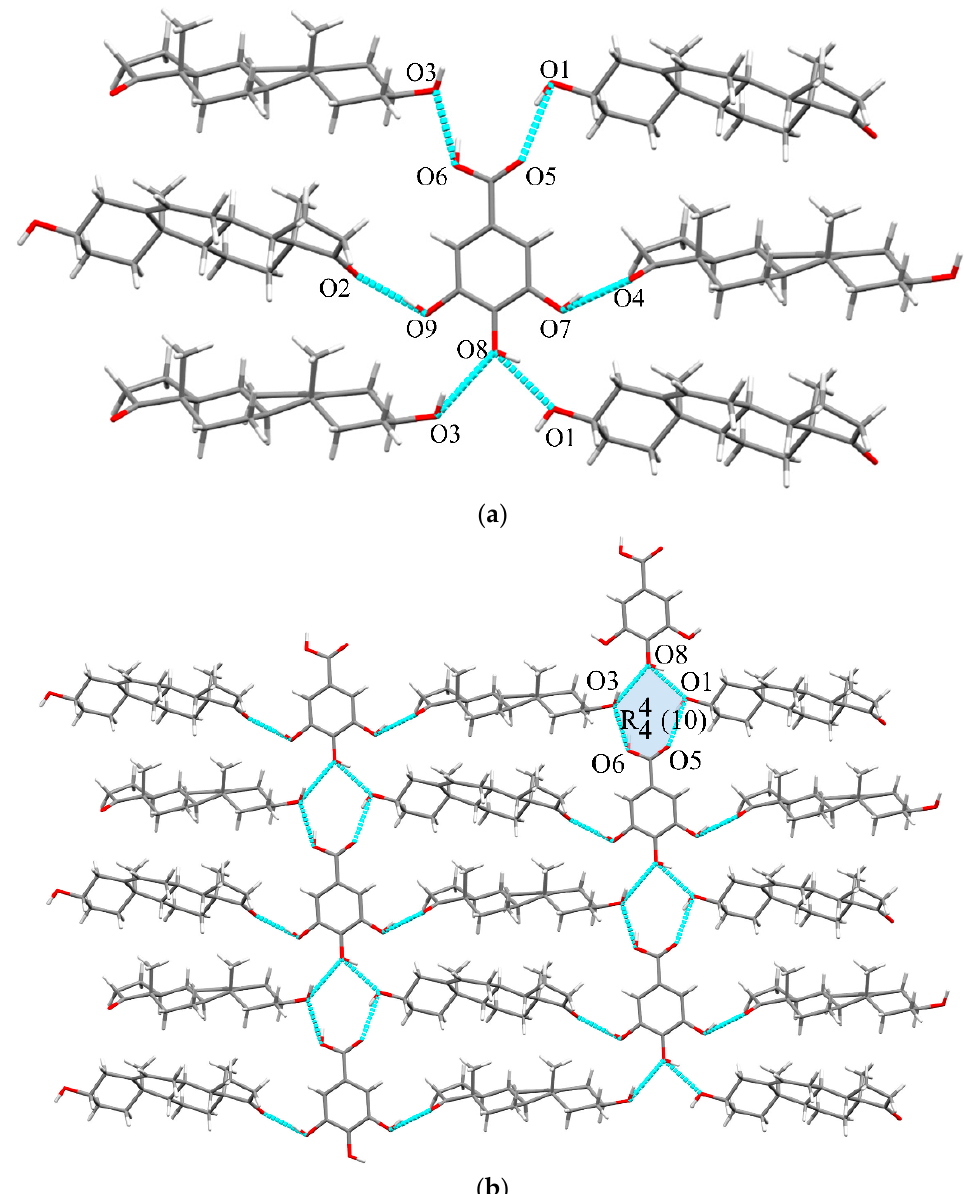
Figure 7. ( a ) Multi-interactions of every GA with six DHEA molecules, and ( b ) 2D supramolecular interactions of DHEA-GA along the ac plane.